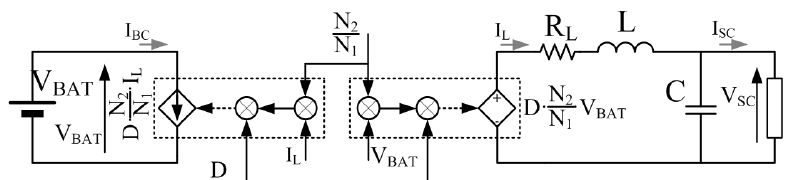
Figure 8. Large-signal averaged model based on ideal components.